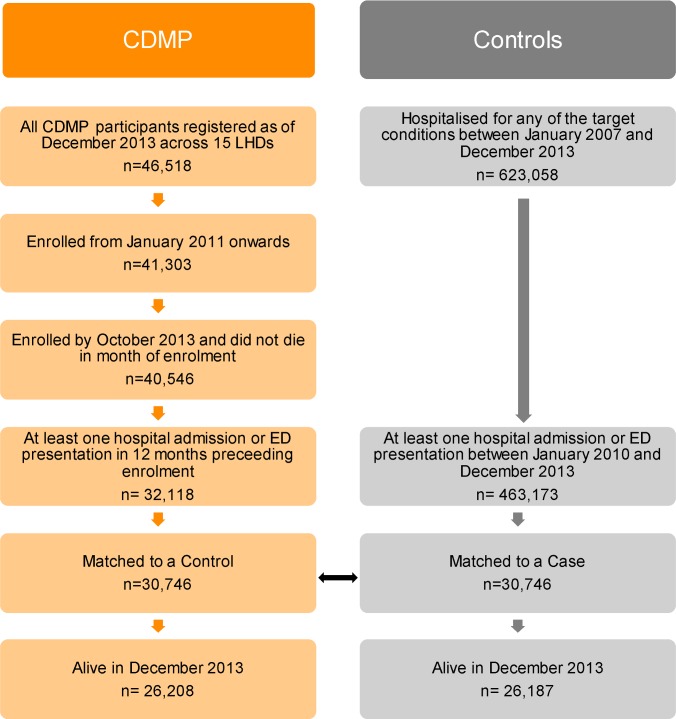
Study flowchart.